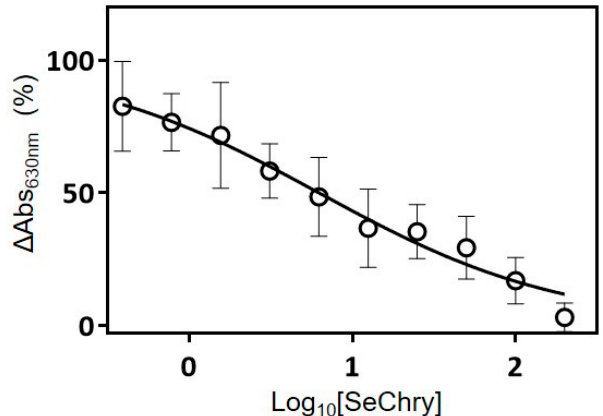
Figure 5. SeChry inhibits human cystathionine β -synthase H 2 S-synthesizing activity. Cystathionine β -synthase (CBS)-catalyzed H 2 S production detected by the methylene blue assay, measured as a function of SeChry concentration in the 0–200- µ M range. Data from four independent experiments (triplicates of each reaction and respective control) were fitted to a log 10 [inhibitor] versus normalized response curve, yielding an apparent half maximal inhibitory concentration (IC 50 ) of 6.3 ± 1.2 µM.